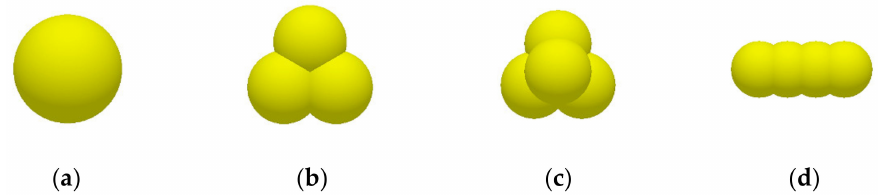
Figure 7. Soil discrete element model. ( a ) Single grain spherical model; ( b ) three-grain flake model; ( c ) four-grain block model; ( d ) four-grain rod model.